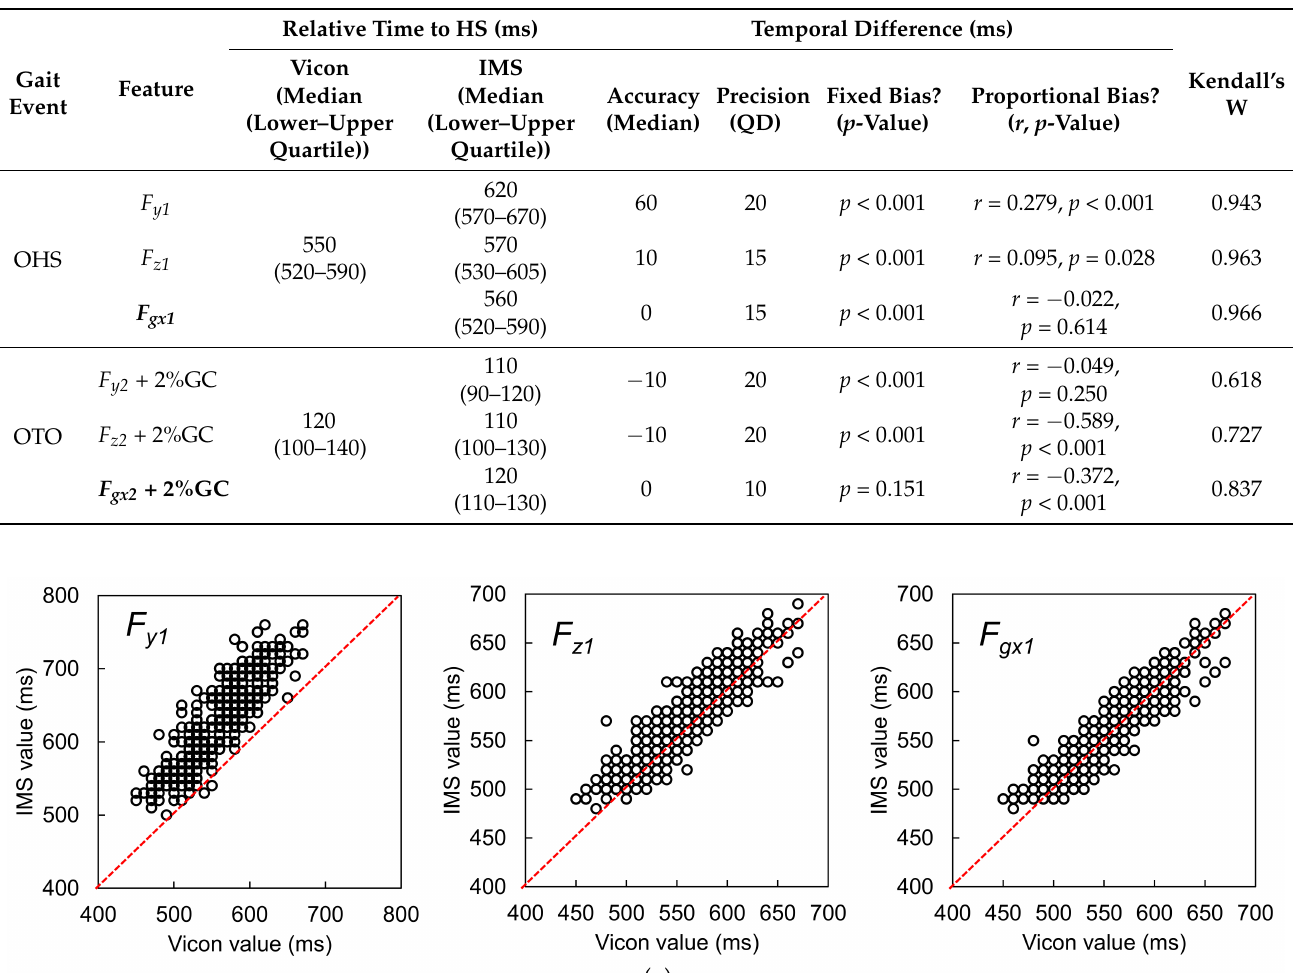
Table 1. Summary of the synchronicity evaluation results for candidate features.